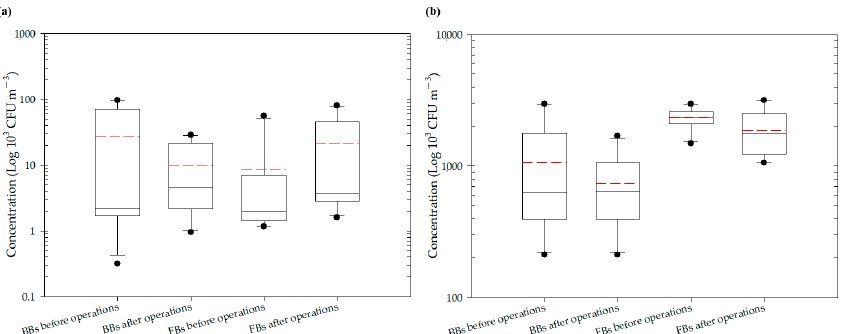
Figure 3. Average total bioaerosol concentrations in the two indoor TWMs: ( a ) Market A; ( b ) Market B.